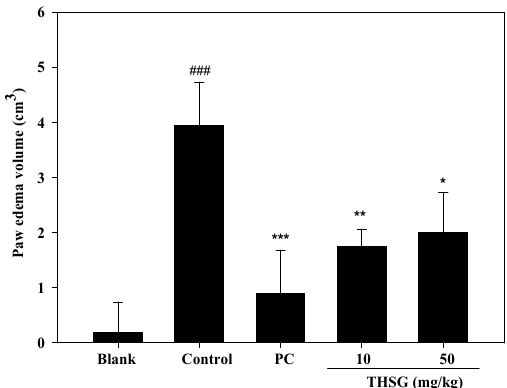
Figure 6. Paw edema volume of rats on mono-iodoacetate (MIA) injection in ankle of rat at 2nd day. Positive control (PC) is indomethacin (2.5 mg/kg). #: control group compared to blank group, ### p < 0.005. *: sample group as compared to control group, * p < 0.05, ** p < 0.001, *** p < 0.005.